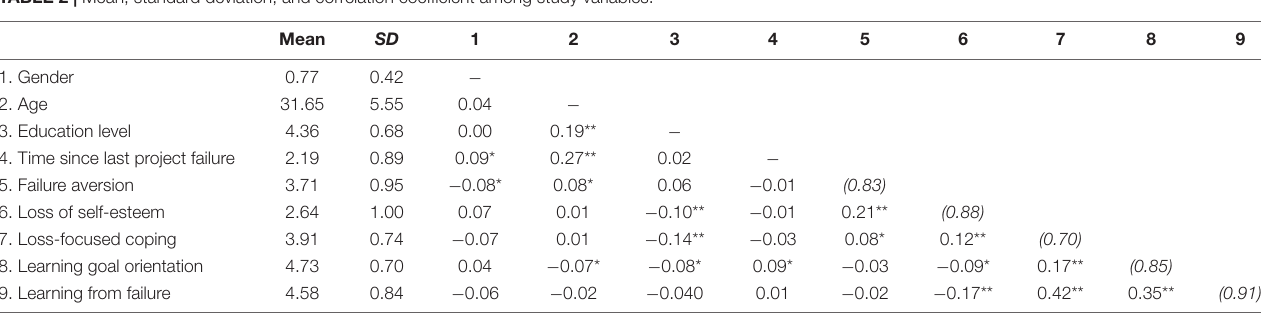
TABLE 2 | Mean, standard deviation, and correlation coefficient among study